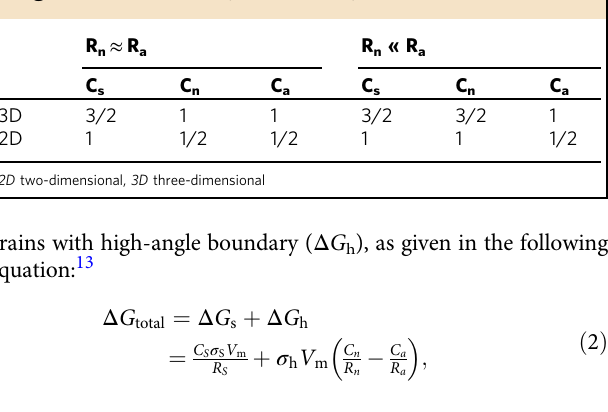
Table 1 Constants C s , C n and C a in equation (2) for 3D and 2D growth when R n ≈ R a and R n « R